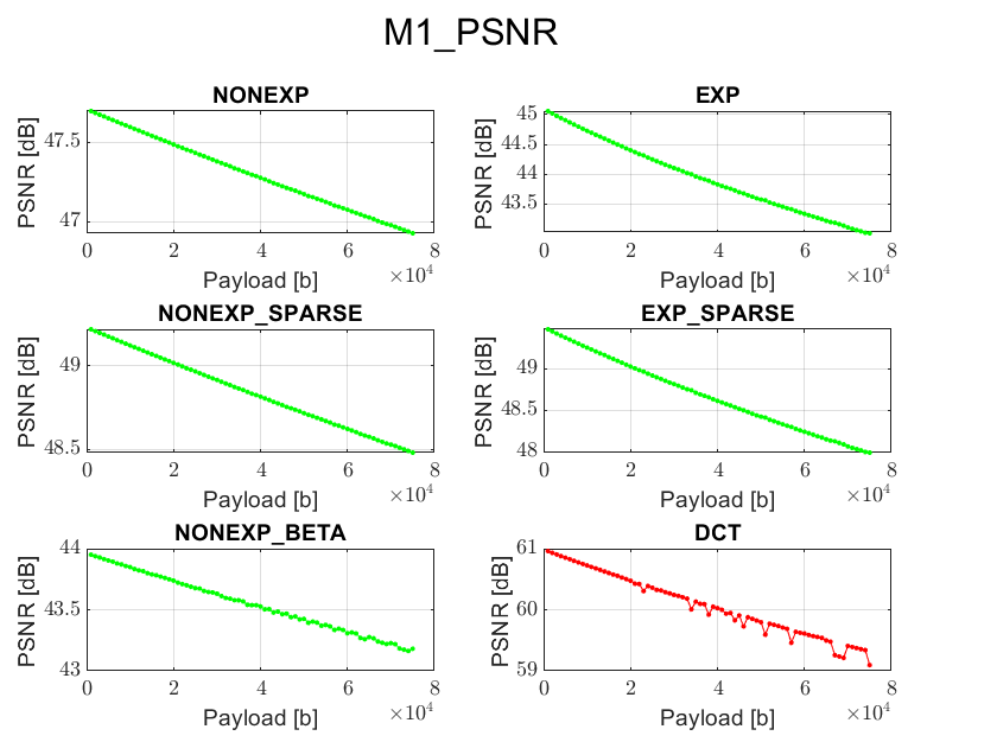
Figure 2. Relation between PSNR and embedded data size for method 1 and all transform types.